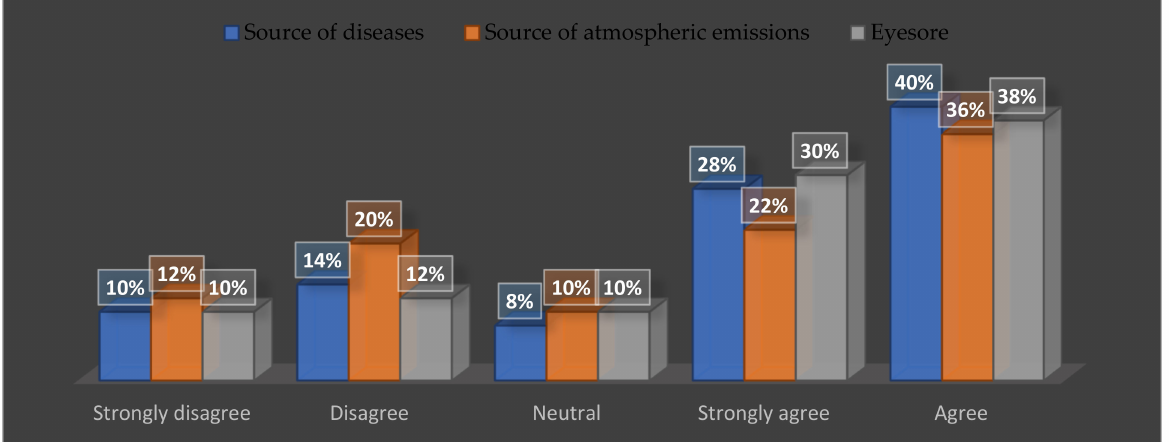
Figure 6. Environmental problems associated with e-waste.